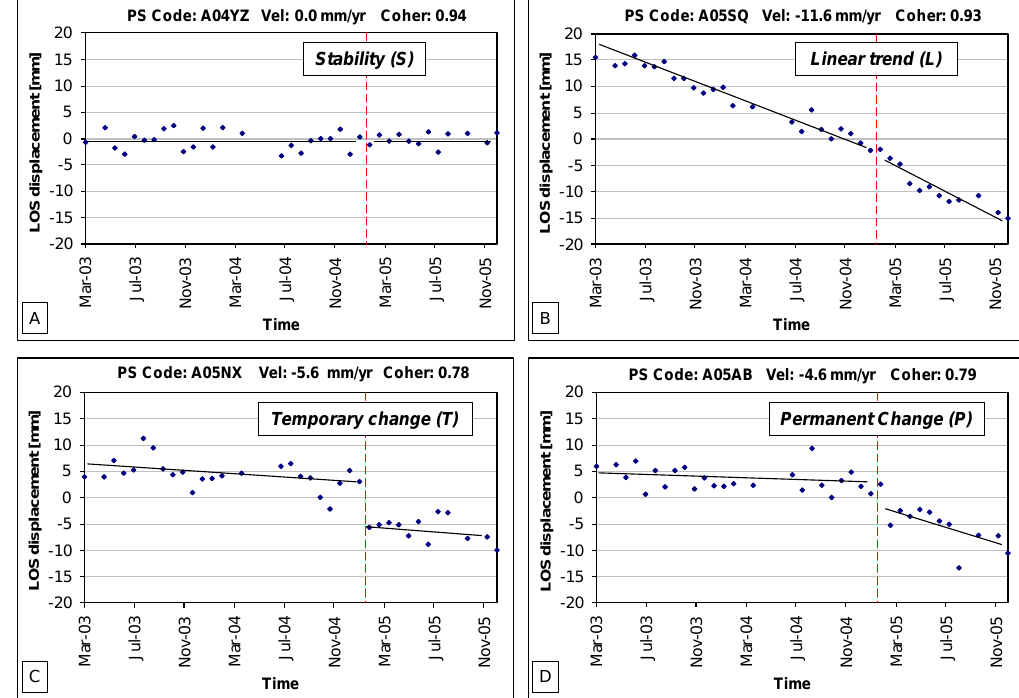
Fig. 10. Examples of RADARSAT PS time series unaffected ( A , class S; B , class L) and affected ( C , class T; D , class P) by the 2005 event (red dashed line). PS code, average deformation rate (Vel.) in 2003–2007 and coherence (Coher.) are also shown for each PS.